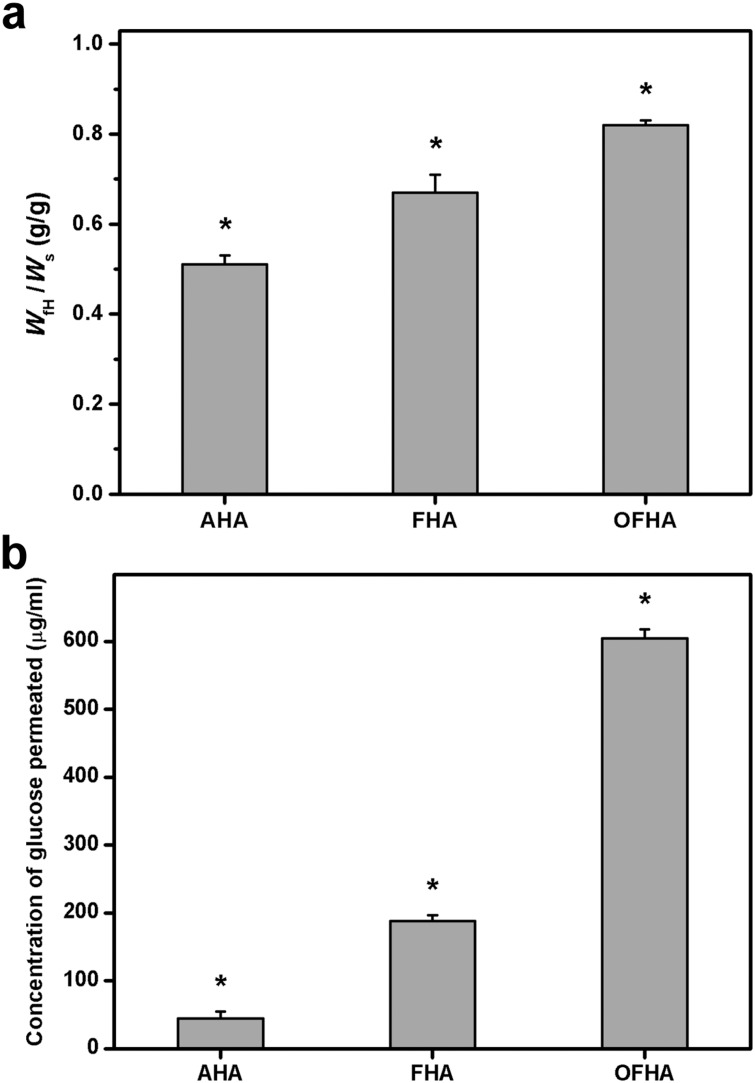
(a) Freezable water content (W
fH/W
s) of various HA carriers. Values are mean ± SD (n = 5). *P < 0.05 vs all groups. (b) Concentration of glucose permeated through various HA carriers at 34°C. Values are mean ± SD (n = 6). *P < 0.05 vs all groups.